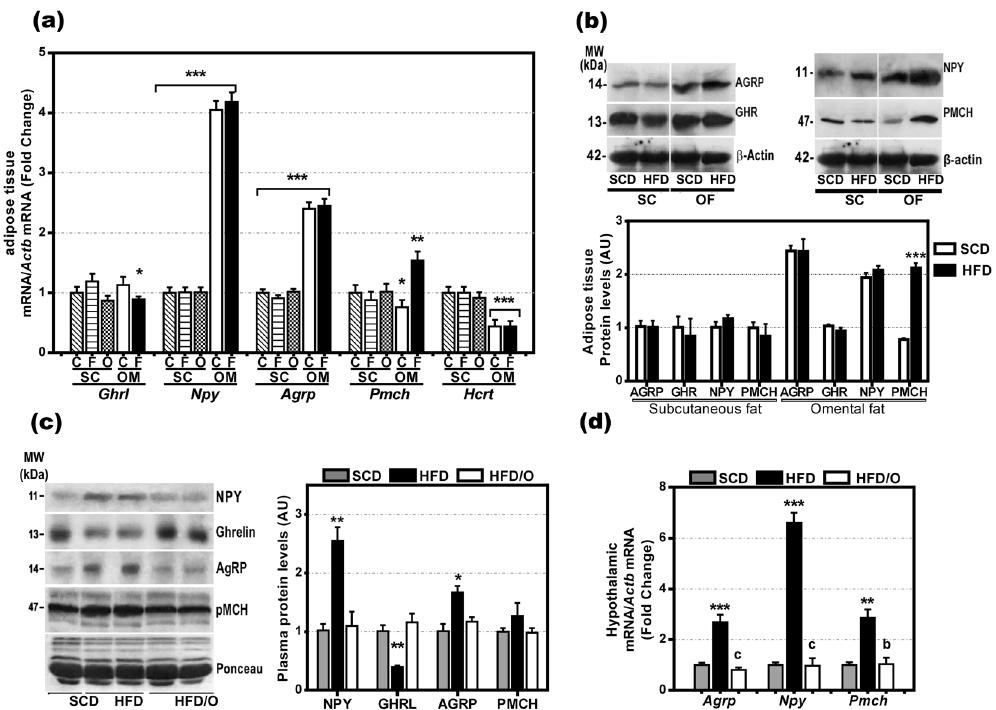
Figure 5. Gene and protein expression of orexigenic factors in omental and subcutaneous fat and hypothalamic gene expression and plasma levels of these factors. ( a ) Gene expression of appetite-stimulatory factors ghrl, Npy, Agrp, Pmch and Hcrt in the greater omentum (OM) and subcutaneous (SC) fat of rats on a standard chow diet (C) or on a high fat diet (F). * p < 0.05; ** p < 0.01; *** p < 0.001 in omental fat as compared with SC fat. ( b ) Protein expression of AGRP, GHR, NPY, PMCH, in the subcutaneous and omental fat of rats fed a SCD or a HFD, respectively. ( c ) Plasma levels of NPY, GHRL, AGRP, and PMCH in SCD-rats, HFD-rats, and HFD/O- rats. Results are given as mean ± S.D. Protein expression in SCD-rats was assumed to be 1. ( d ) Hypothalamic gene expression of Npy, Agrp , and Pmch . Results are given as mean ± S.D., * p < 0.05; ** p < 0.01 *** p < 0.001 vs . SCD-rats. b p < 0.01; c p < 0.001 vs .